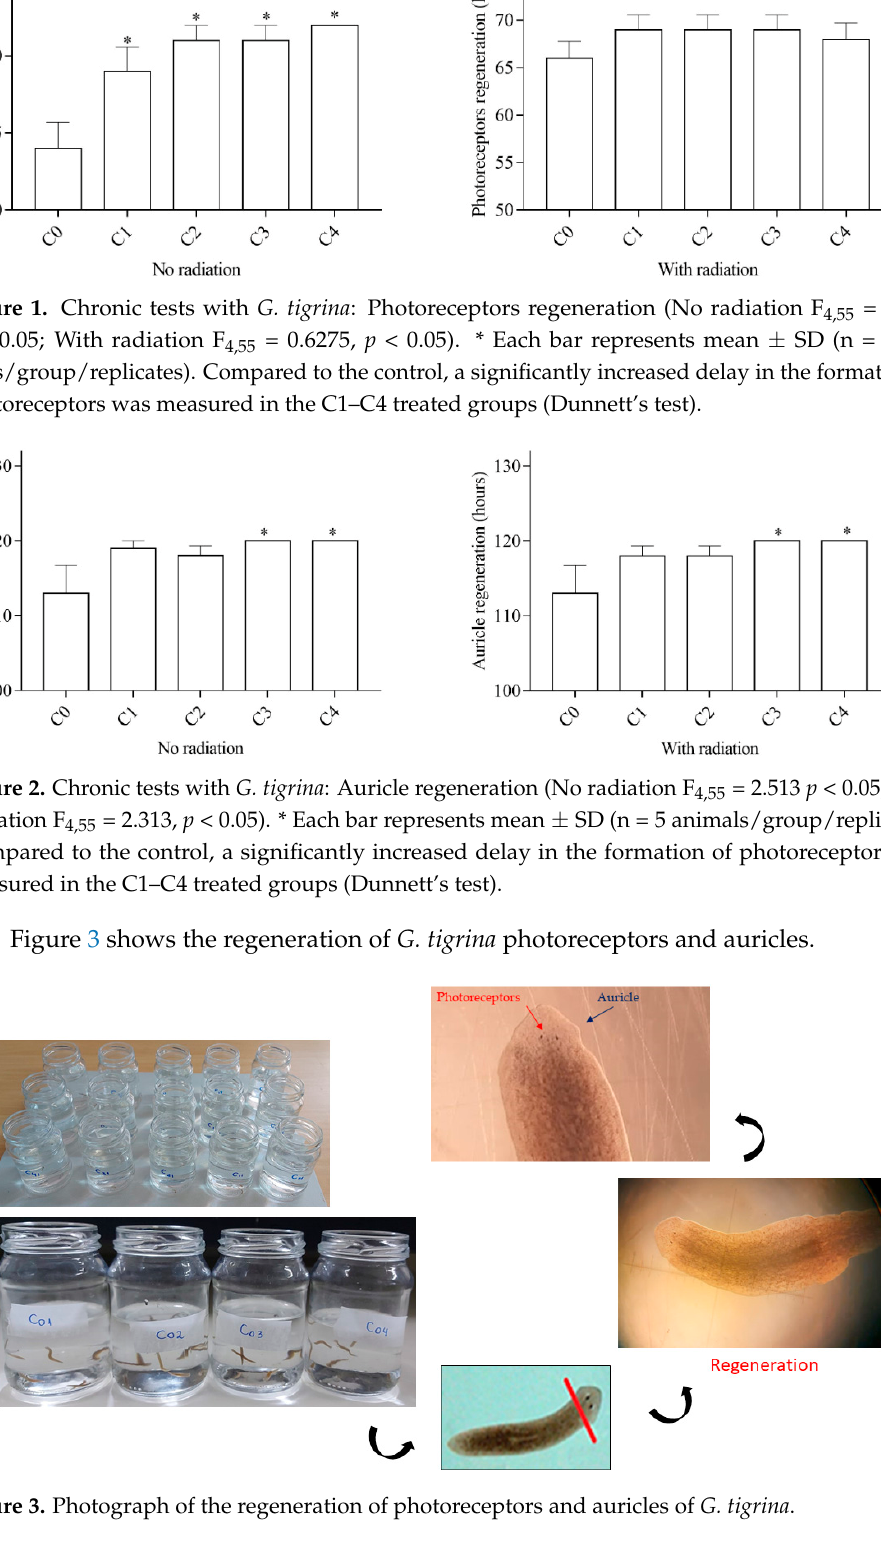
Figure 1. Chronic tests with G. tigrina : Photoreceptors regeneration (No radiation F 4,55 = 6.994 p < 0.05; With radiation F 4,55 = 0.6275, p < 0.05). * Each bar represents mean ± SD (n = 5 animals/group/rep- licates). Compared to the control, a significantly increased delay in the formation of photoreceptors was measured in the C1–C4 treated groups (Dunnett’s test).